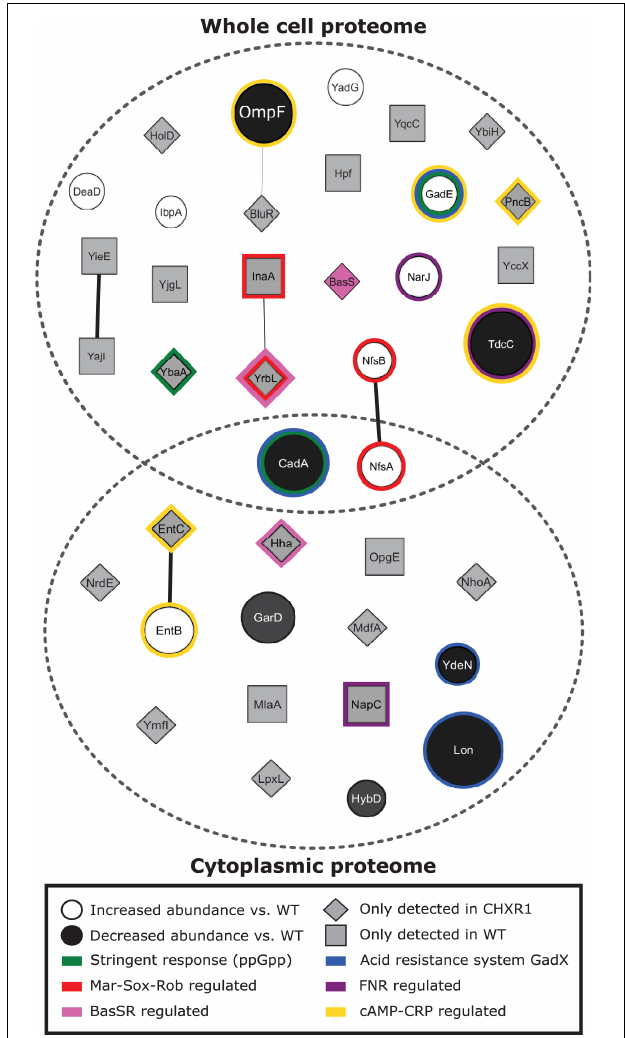
FIGURE 3 | A network diagram summary of significantly identified proteins determined from the CHXR1 isolate and WT proteomic analyses. The network diagram was generated using Cytoscape v3.7.2 (Shannon et al., 2003) using the StringApp v1.5.0 software package (Doncheva et al., 2019). As summarized in the panel legend, significantly altered protein abundances are represented as circles with protein names and indicate proteins that differed between WT and CHXR1 in both the WC and CY proteomes. The size of the protein circles represents the degree of fold change from the WT proteome, where white filled circles represent CHXR1 proteins with increased abundance and black filled circles represent CHXR1 proteins with decreased abundance. Gray filled squares and diamonds represent WT and CHXR1 proteins respectively, that were not detected in the opposite (WT or CHXR1) proteome. Known regulatory systems influencing protein accumulation are outlined by color according to the bottom panel